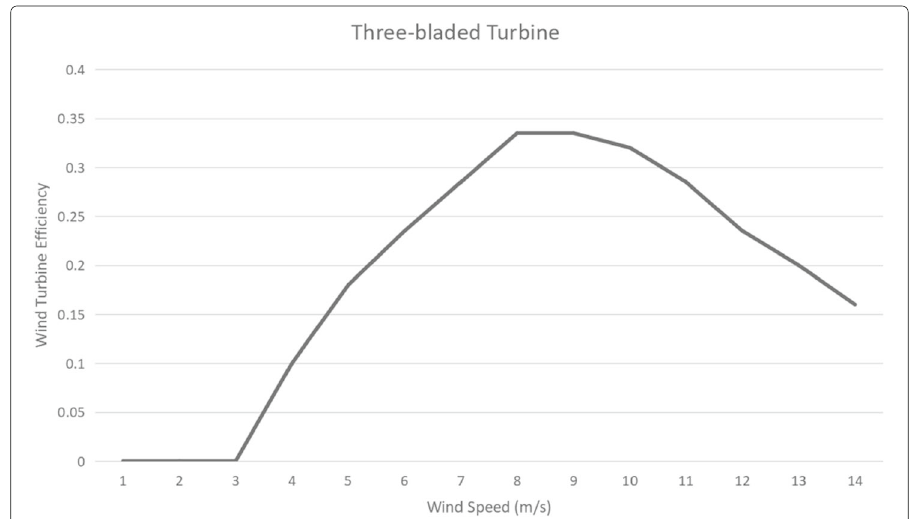
Fig. 1 Three-bladed efficiency curve of the wind turbine, from (Bukala et al. 2015)